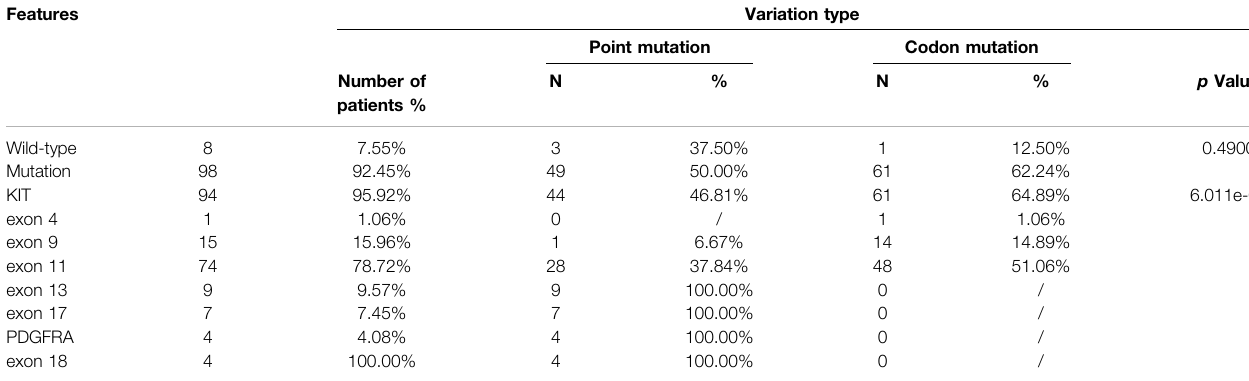
TABLE 2 | The genomic features of 106 GIST